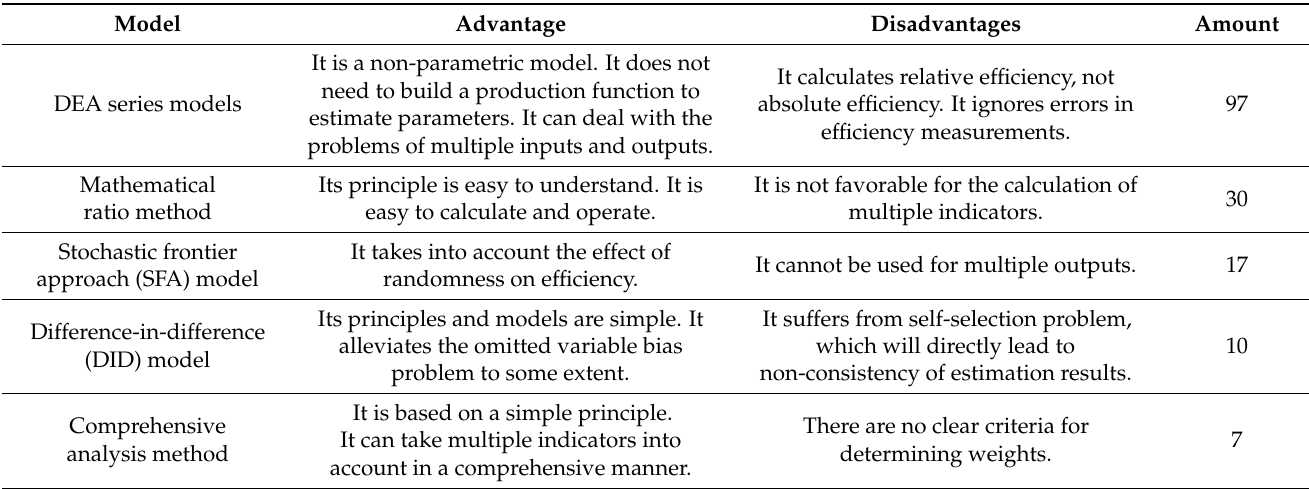
Table 1. Measurement model for land use